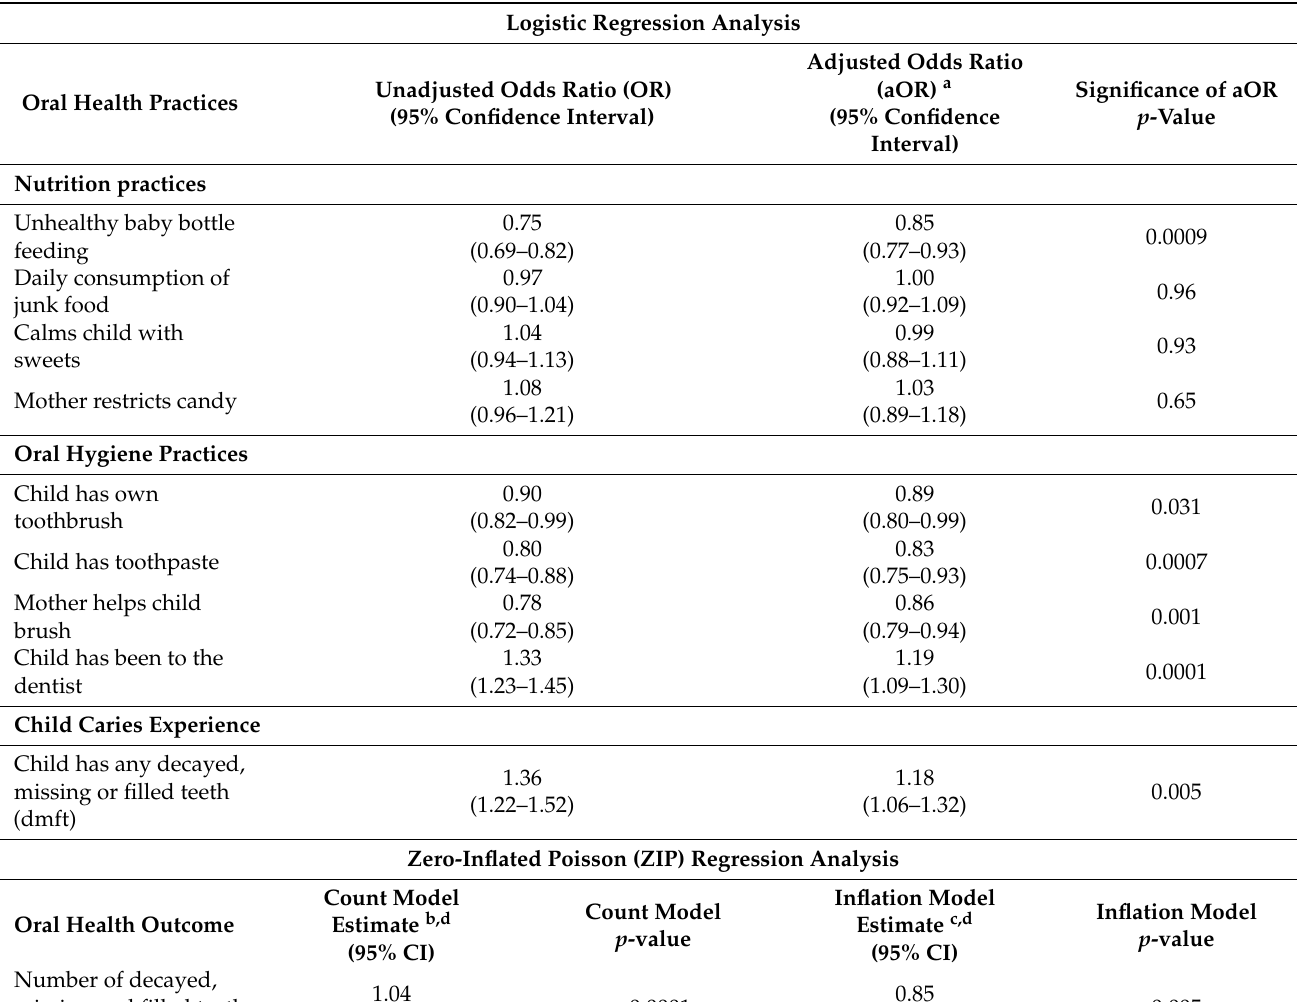
Table 4. Association between number of children, oral health practices, and caries experience a